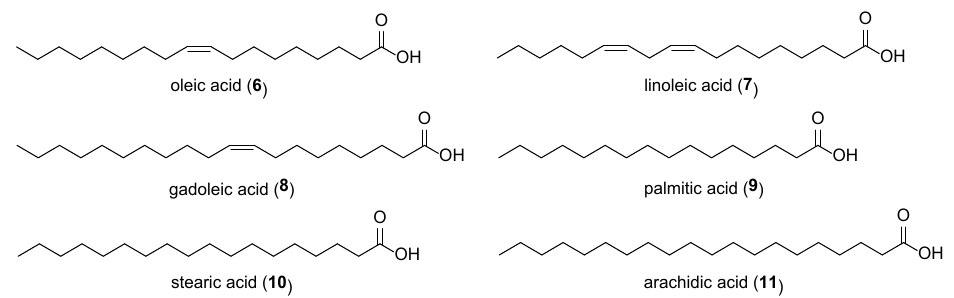
Figure 3. Chemical structures of saturated and unsaturated fatty acids isolated from Melia volkensii . Plants 2020 , 9 , 143